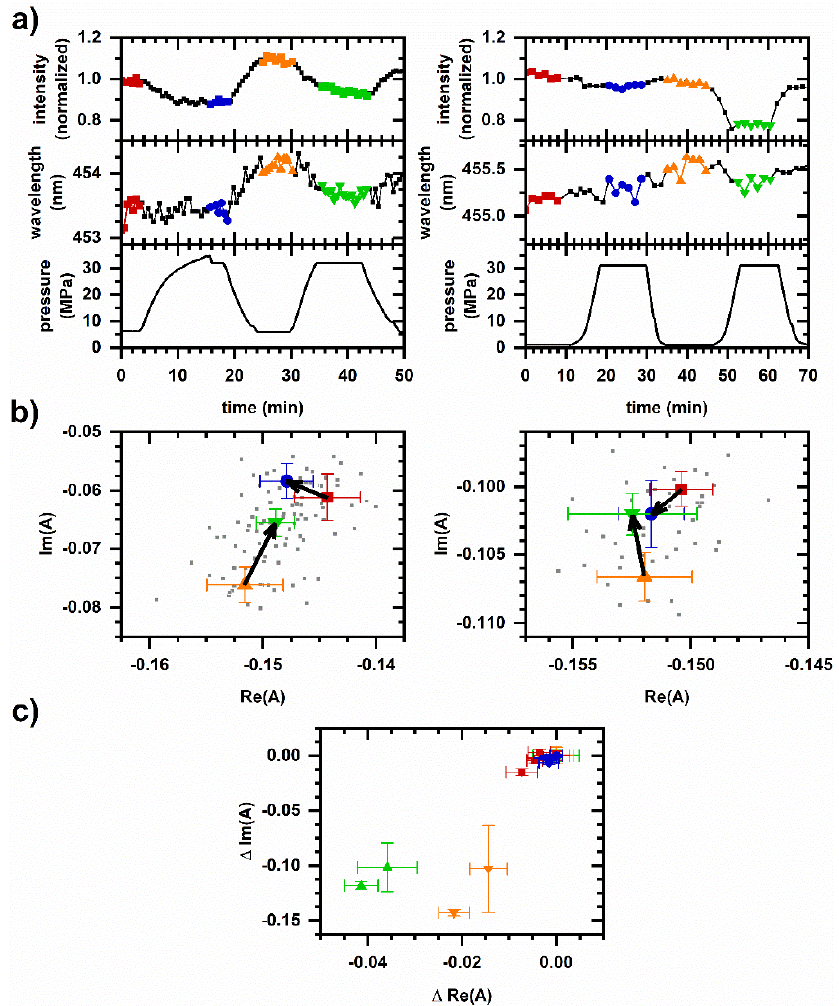
Figure 2. Cellular autofluorescence response to pressure cycling. Representative results are shown; each column features data from an independently prepared sample. Behavior is reproduced on N = 5 independently prepared samples. ( a ) Autofluorescence intensity and average emission wavelength versus time. Spectrally integrated autofluorescence intensity is normalized to the average intensity prior to the initial pressurization. An autofluorescence wavelength is calculated as an intensity-weighted average emission wavelength. The measured pressure is also shown. ( b ) Phasor plots. Small symbols are phasors calculated from individual measurements. Large symbols are average and standard deviations of phasor values. Color corresponds to time intervals of constant pressure over which phasor values are averaged; the corresponding data points are shown in the same color in Figure 2a. Arrows indicate phasor shift directions upon pressurization. The intensity, average emission wavelength, and phasor are calculated from a measured spectrum using the first 400 pixels (400–500 nm wavelength). ( c ) Comparison of phasor plots for cyanide and pressure cycling data. Phasor values are shifted so that the initial phasor is at the origin. The datasets are red—Pressure cycling, Figure 2b, left; blue—Pressure cycling, Figure 2b, right; green—Cyanide response at ambient pressure, Figure 1c, left; and orange—Cyanide response at 32 MPa, Figure 1c, right.